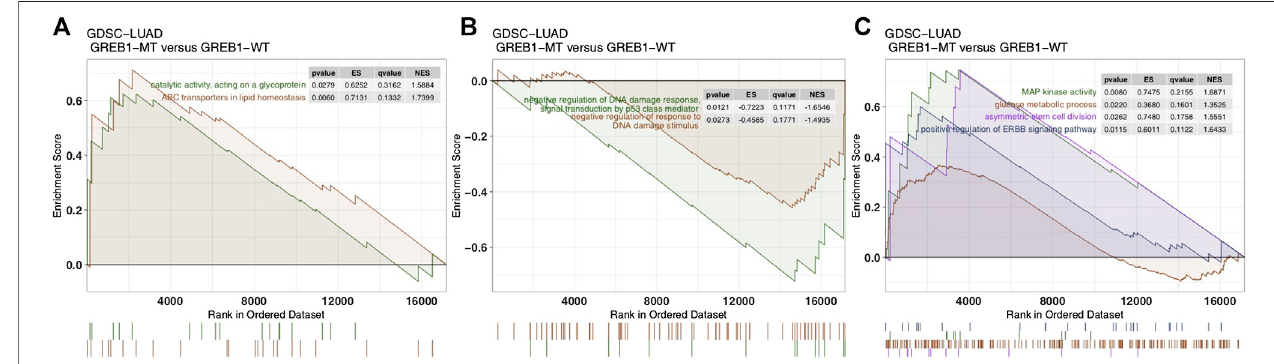
FIGURE 4 | Transcriptome traits in GDSC-LUAD cell lines with or without GREB1 mutations. (A – C) GSEA of hallmark gene sets downloaded from the MSigDB database.Alltranscriptswererankedbylog2(foldchange)betweentheGREB1-MTandGREB1-WTLUADcelllines.Eachrunwasperformedwith1,000permutations. GDSC, Genomics of Drug Sensitivity in Cancer; LUAD, lung adenocarcinoma; GSEA, gene set enrichment analysis; MT, mutant; WT, wild-type.